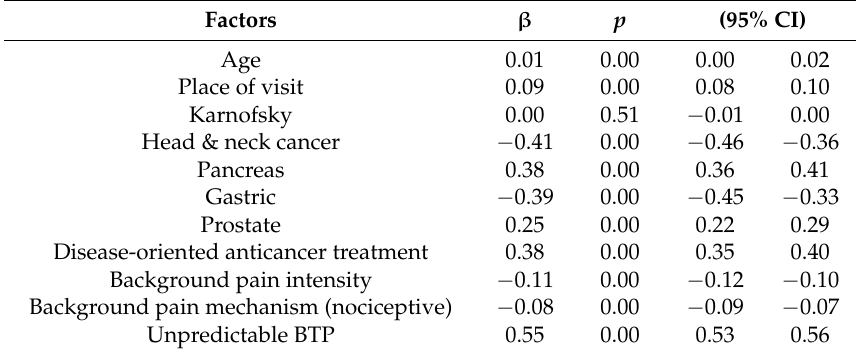
Table 6. Multivariate analysis for duration of untreated BTP